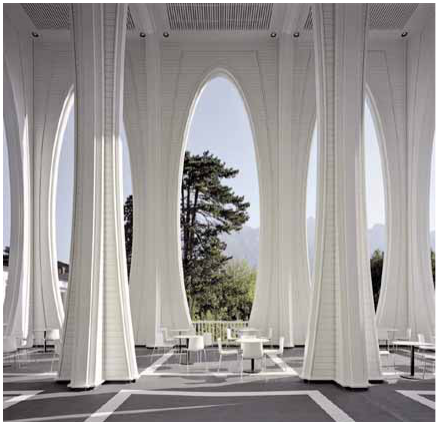
Fig. 29. Glued wooden constructions of aqua park and sauna complex in Druskininkai, archit. office “Vilniaus